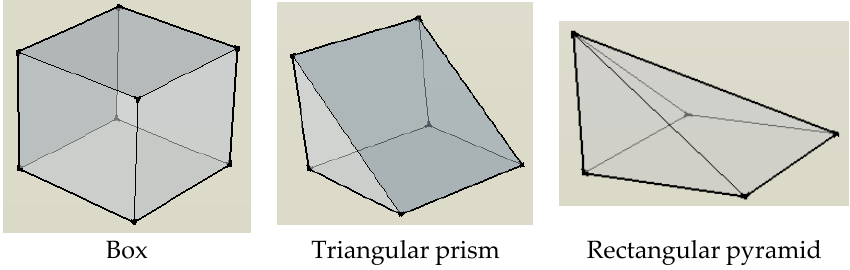
Figure 1. Examples of elementary geometric features that are used in constructive solid geometry (CSG) modeling.